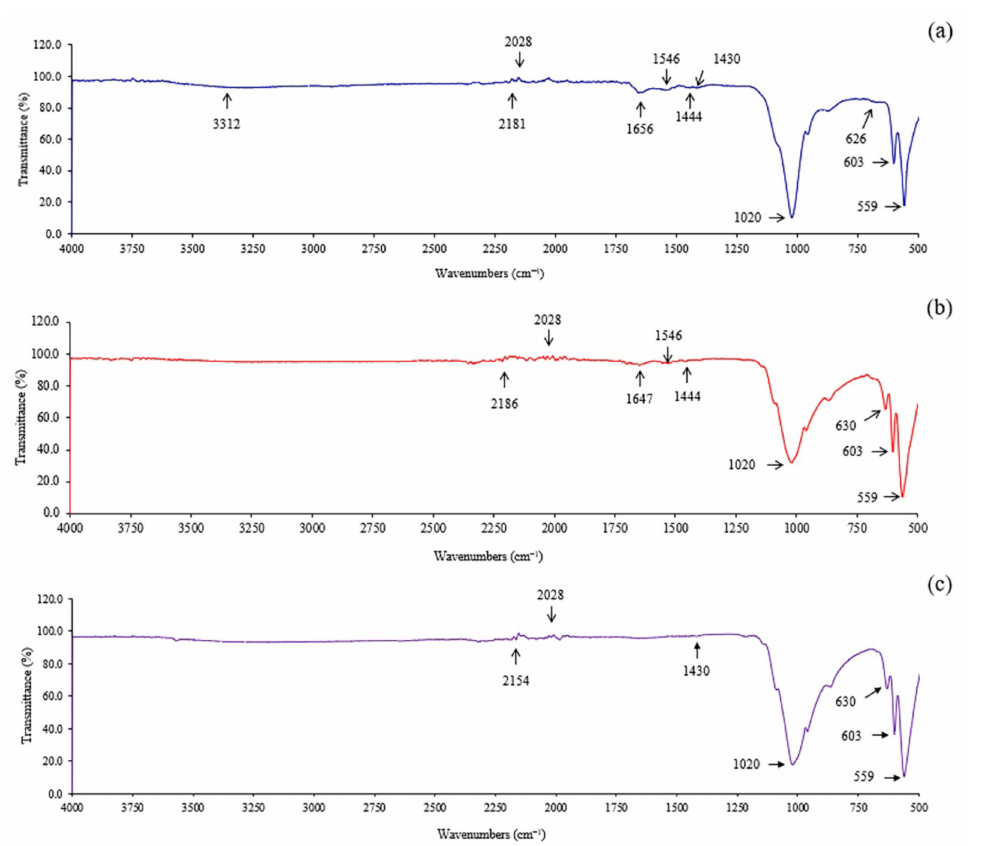
Figure 9. FTIR spectra of extracted ( a ) and commercial hydroxyapatite ( b ) after adsorption of BSA and commercial hydroxyapatite ( c